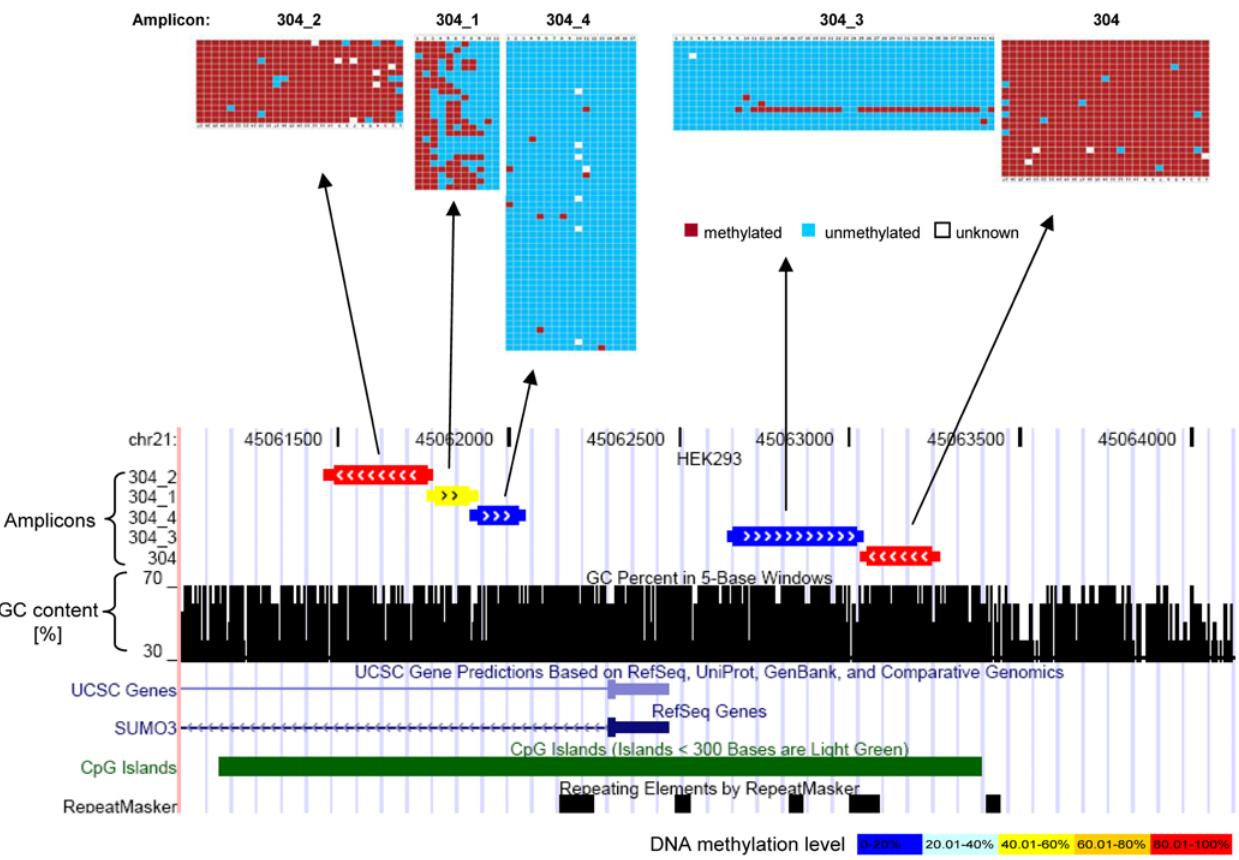
Figure 3. Example of amplicons located on the same CpG island but showing different DNA methylation levels and decreasing methylation when approaching the TSS of the gene. The figure shows the position of these amplicons in the UCSC genome browser in the lower part and it schematically displays the methylation pattern of five amplicons determined in HEK293 in the upper part. Each row corresponds to one sequenced clone of the bisulfite PCR product. Each column corresponds to one CpG site. The color code indicates the methylation state of the individual CpG site in each clone.